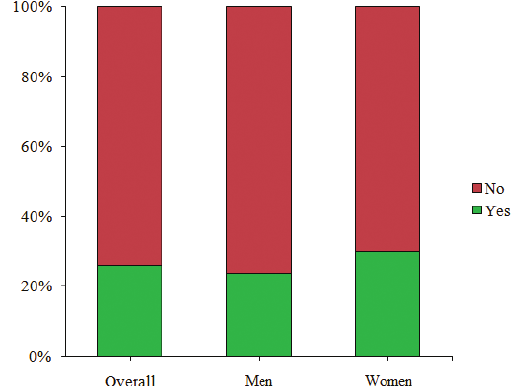
Figure A13. Responses to K13: “Before completion of